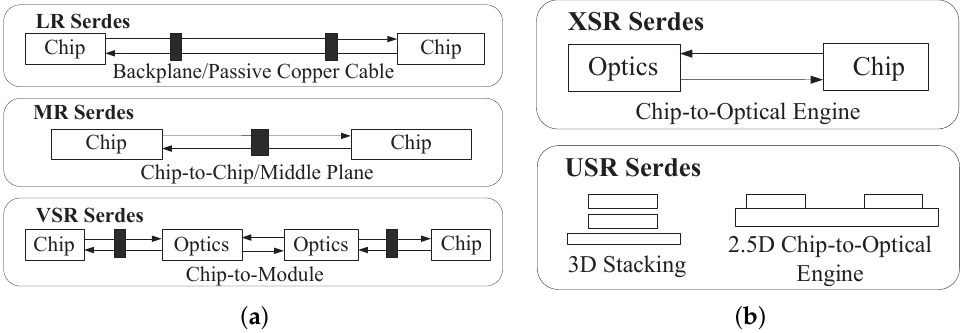
Figure 2. Classification and Application of Typical Serial Interfaces; ( a ) Classification of Serial Interfaces, ( b ) Application of Serial